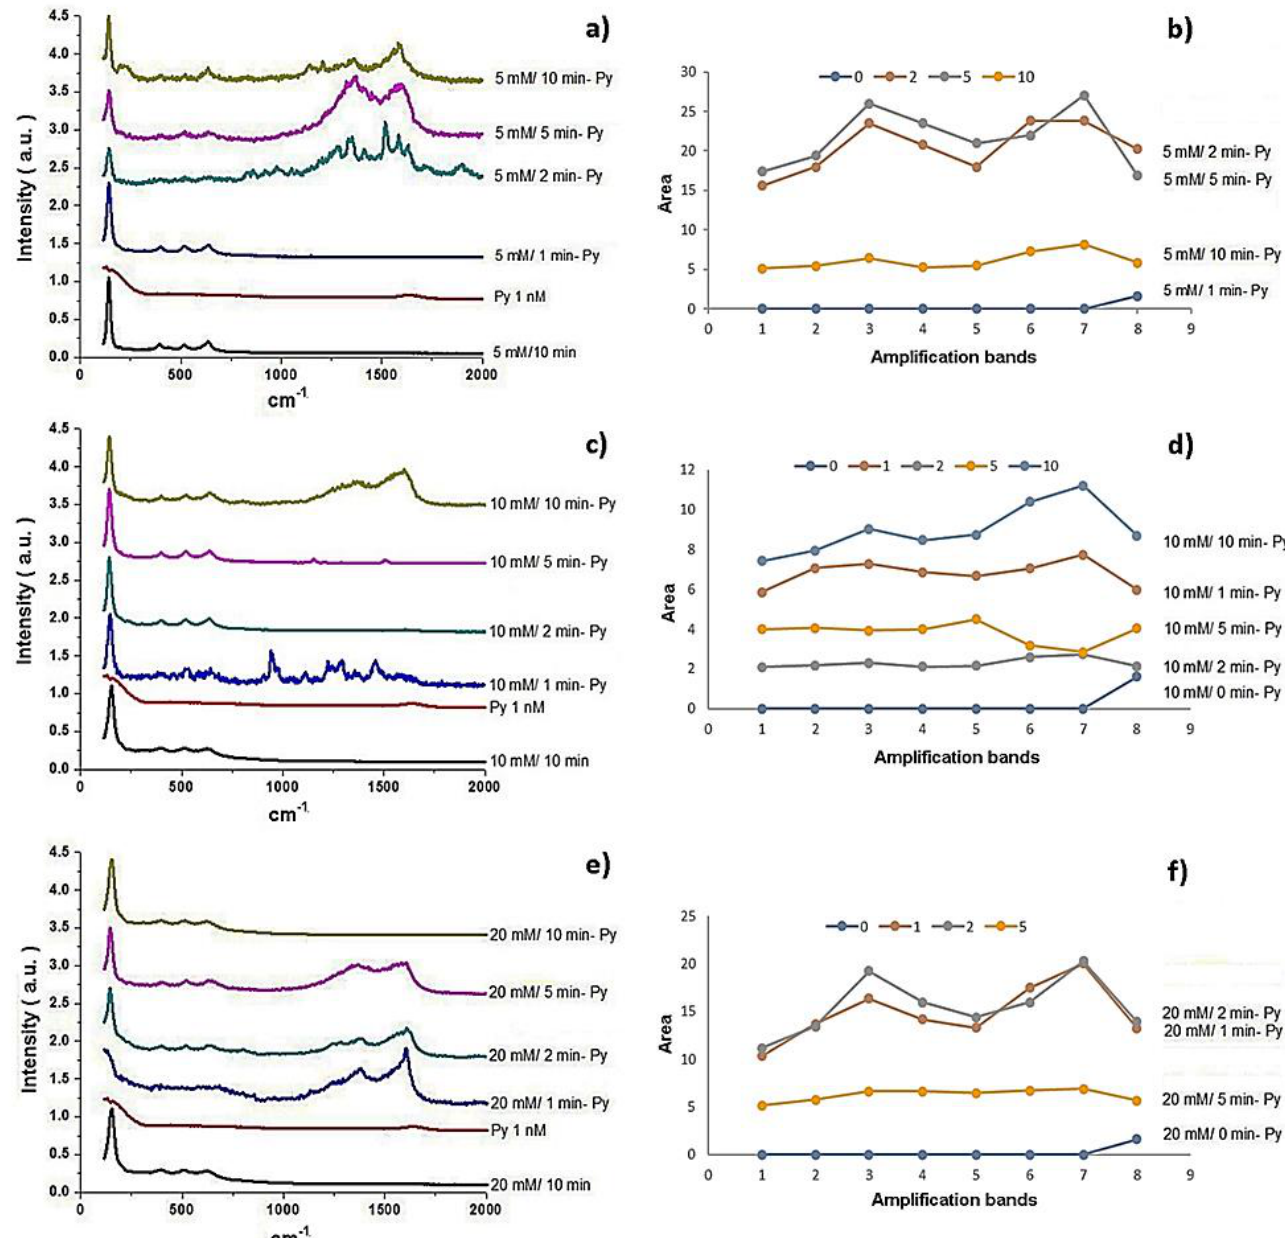
Figure 9. Raman spectra of 1 nM pyridine on the supports doped at different times and concentration: ( a , b ) AgNO 3 at concentration of 5 mM (at 1, 2, 5 and 10 min); ( c , d ) AgNO 3 at concentration of 10 mM (at 1, 2, 5 and 10 min); ( e , f ) AgNO 3 at concentration of 20 mM (at 1, 2, 5 and 10 min). Note: pyridine solution and the supports alone are annexed.